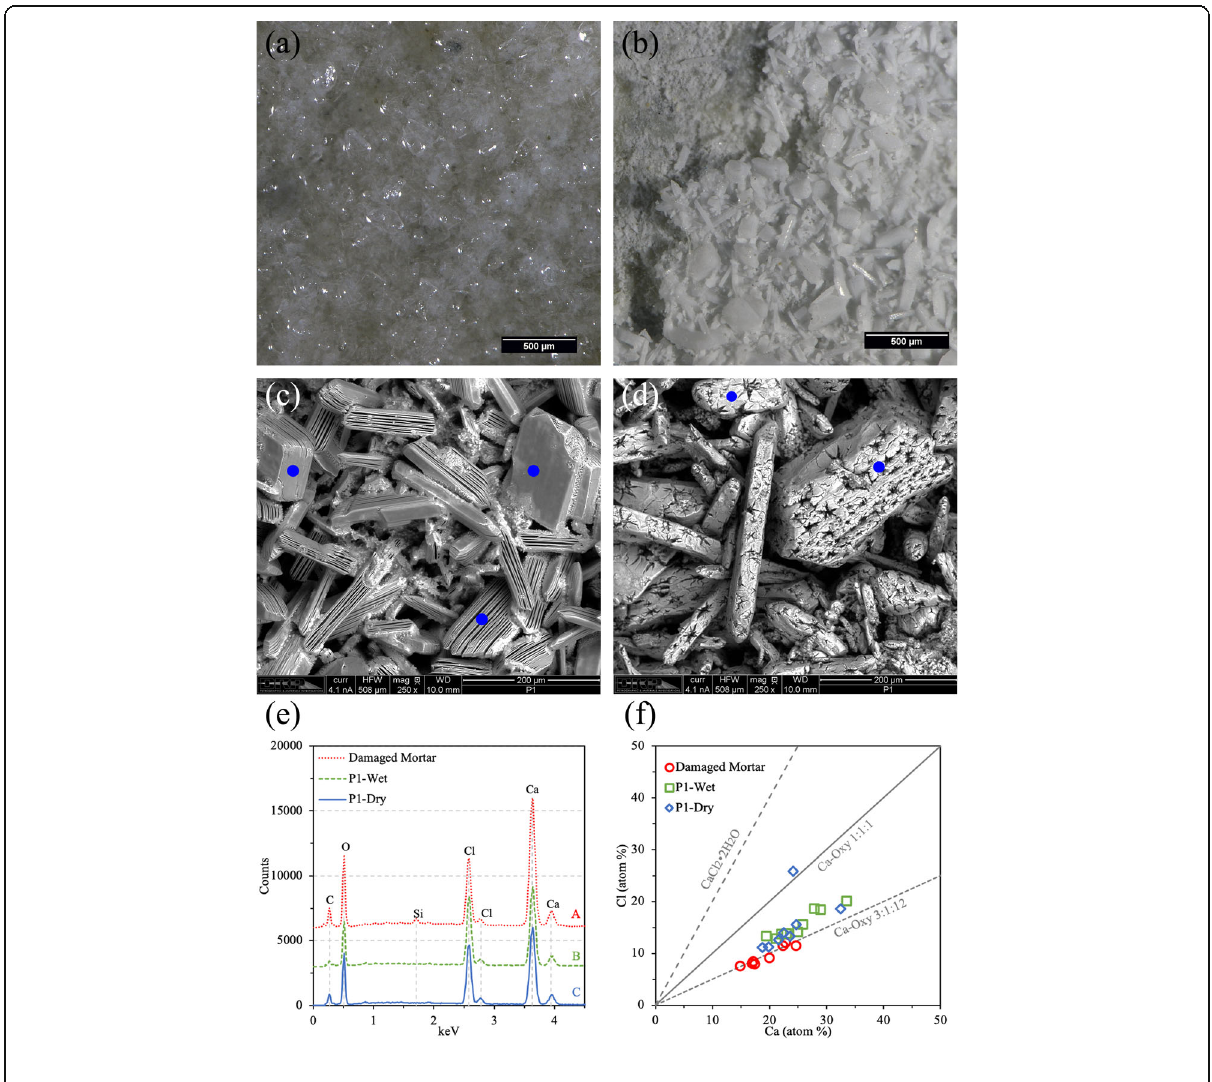
Fig. 8 a - b RLP and c - d BSE images of Ca-Oxy (blue solid dots) on a fracture surface of the damaged lab-cast paste in ( a / c ) an originally wet condition and ( b / d ) a dried condition, respectively. e EDX spectra obtained from zones in Figs. 7c and 8c-d. f Relationship between Ca and